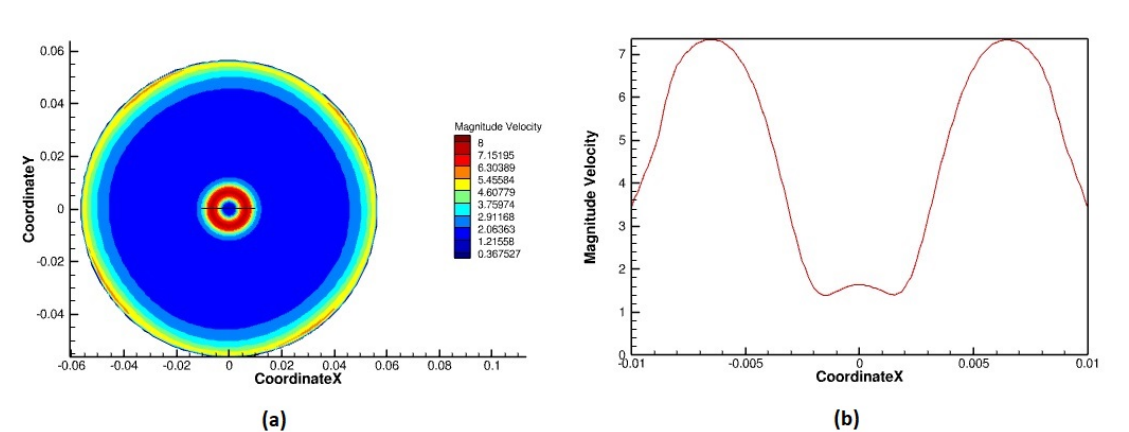
Figure 9. Velocity magnitude profile for the cold flow case with RNG k- (cid:101) turbulence model at the z-plane = 5 mm ( a ) and velocity magnitude profile 2D plot along the black line on z-plane = 5 mm ( b ).